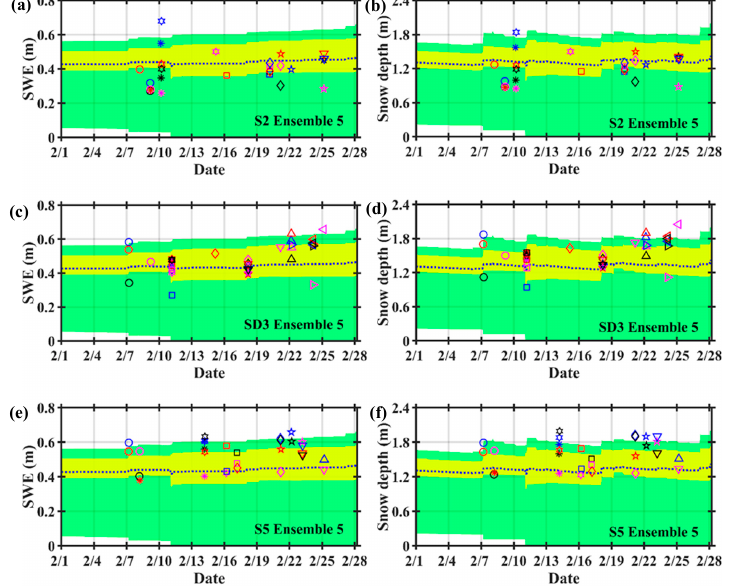
Figure 4. Time series of Ensemble 5 SWE and snow depth predictions on February 17 at S2 ( a , b ), SD3 ( c , d ), and S5 ( e , f ). The blue dotted line is the Ensemble 5 mean. The green envelope identifies the minimum and the maximum values among all ensemble members. The yellow envelope delimits the 25th and 75th percentiles. The symbols represent the SnowEx’17 snowpit observations following the convention in Table